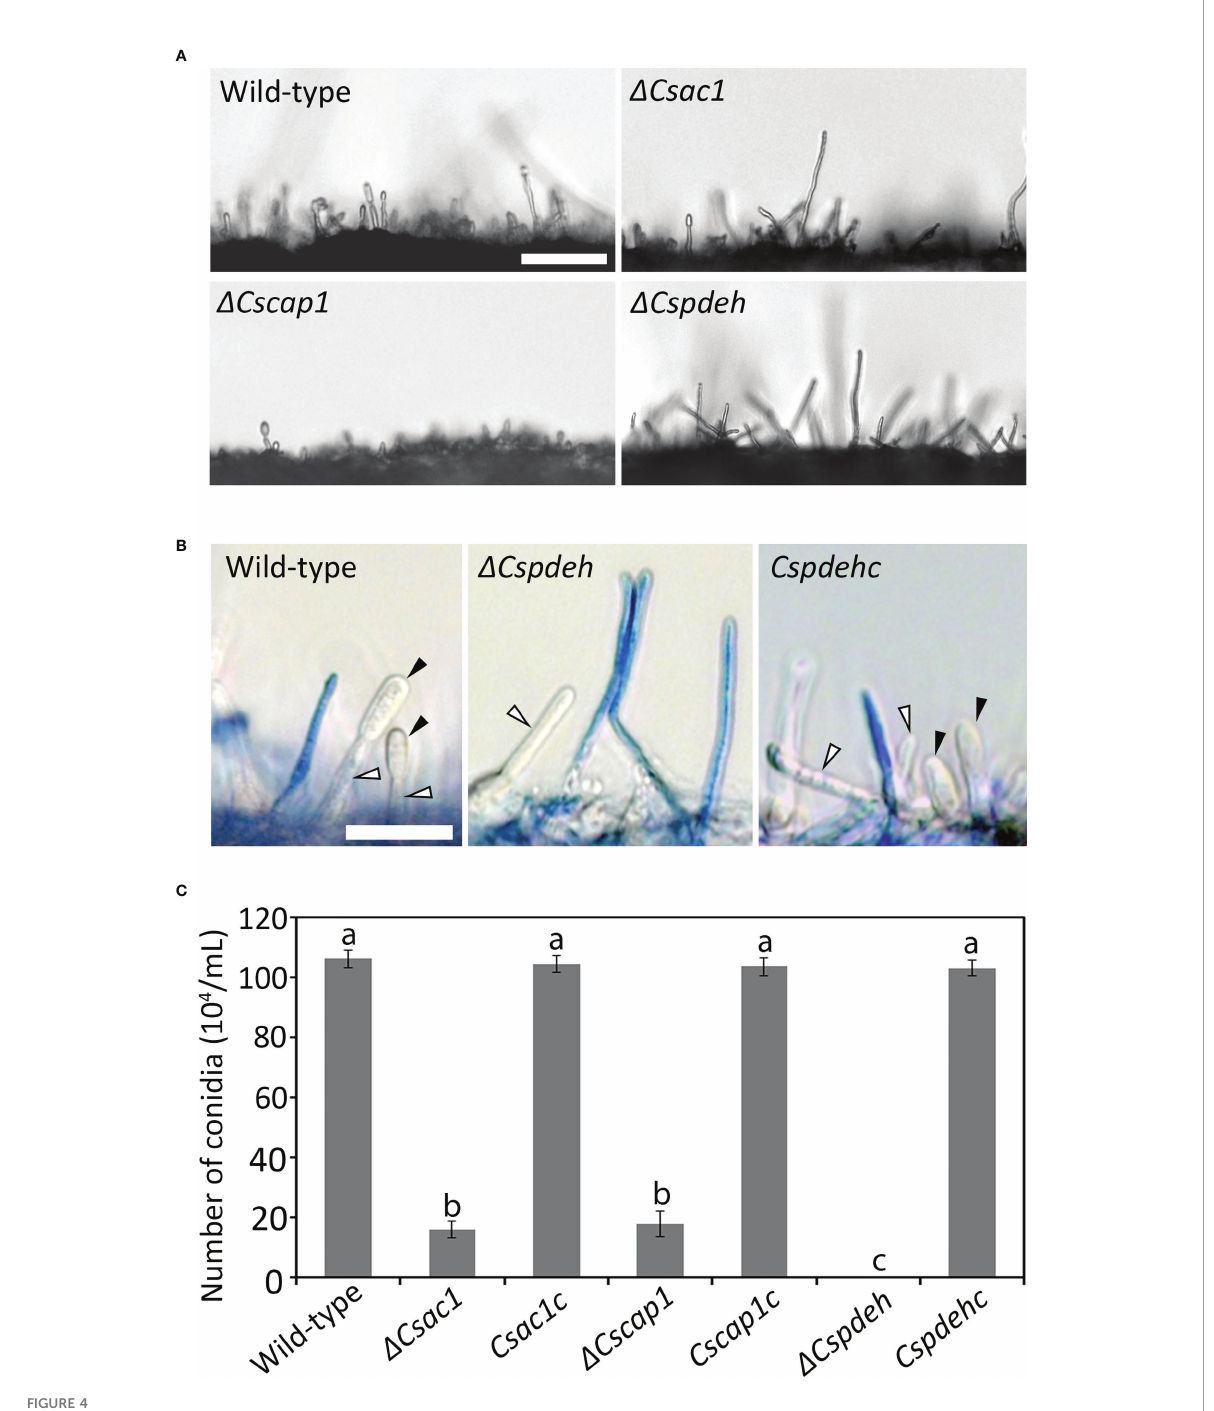
FIGURE 4 Roles of CsAc1 , CsCap1 , and CsPdeH in conidiation. (A) Microscopic visualization of conidiation. The indicated strains were inoculated onto oatmeal agar (OMA) and incubated for 3 days without light. Mycelial agar plugs from 3-day-old OMA were placed in a humid plastic box and incubated with light for 5 hours. Scale bar, 50 m m. (B) Microscopic visualization of conidiophores under inductive conditions. Aerial hyphae (blue) other than conidiophores were stained using lactophenol aniline blue solution. Black and white triangles indicate conidia and conidiophores, respectively. Scale bar, 20 m m. (C) Quantitation of conidiation. The indicated strains were inoculated into PDA and incubated under a cycle of 5 days of darkness and 2 days light. Error bars show standard deviations and different letters in the same group indicate signi fi cant differences estimated using Duncan ’ s test (P <